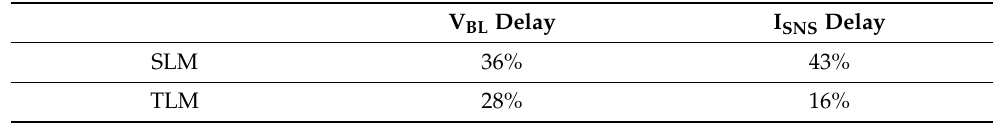
Table 2. Reduction in delay with optimum PE